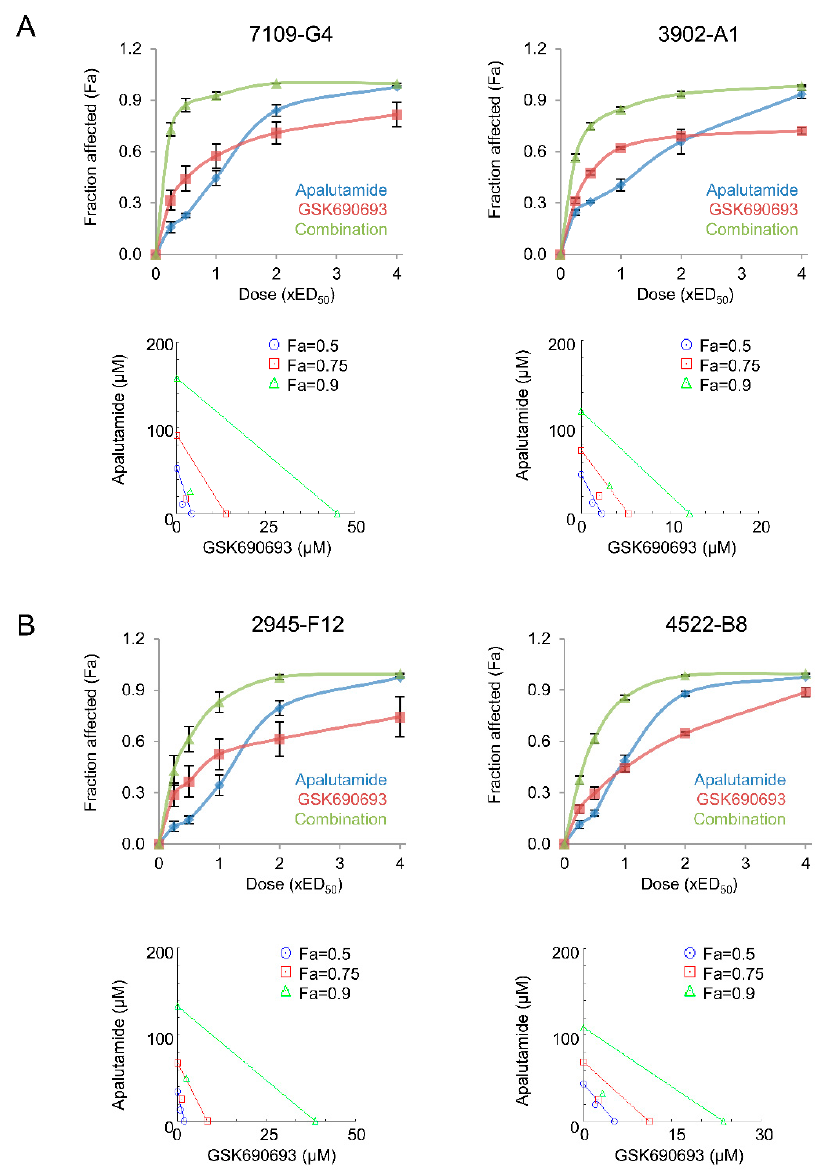
Figure 5. Apalutamide and AKT inhibition synergizes to suppress mouse prostate cancer cell viability in vitro. Mouse prostate cancer cell lines established from Pten -deficient castration-naïve prostate cancer, (CNPC) 7109-G4 and castration-resistant prostate cancer (CRPC), 2945-F12 and Pten/Trp53 -deficient CNPC, 3902-A1 and CRPC, 4522-B8 were treated with apalutamide and GSK690693 alone or in combination for 96 h constant ratio combinations based on the effective doses resulting in 50% growth inhibition (ED 50 ) and synergy measured by the Chou–Talalay combination index (CI), see Table 1. Dose–effect curves and representative isobolograms for CNPC- ( A ) and CRPC-derived ( B ) cells. Data represent the mean values ± SE of four independent experiments performed in quadruplicate.